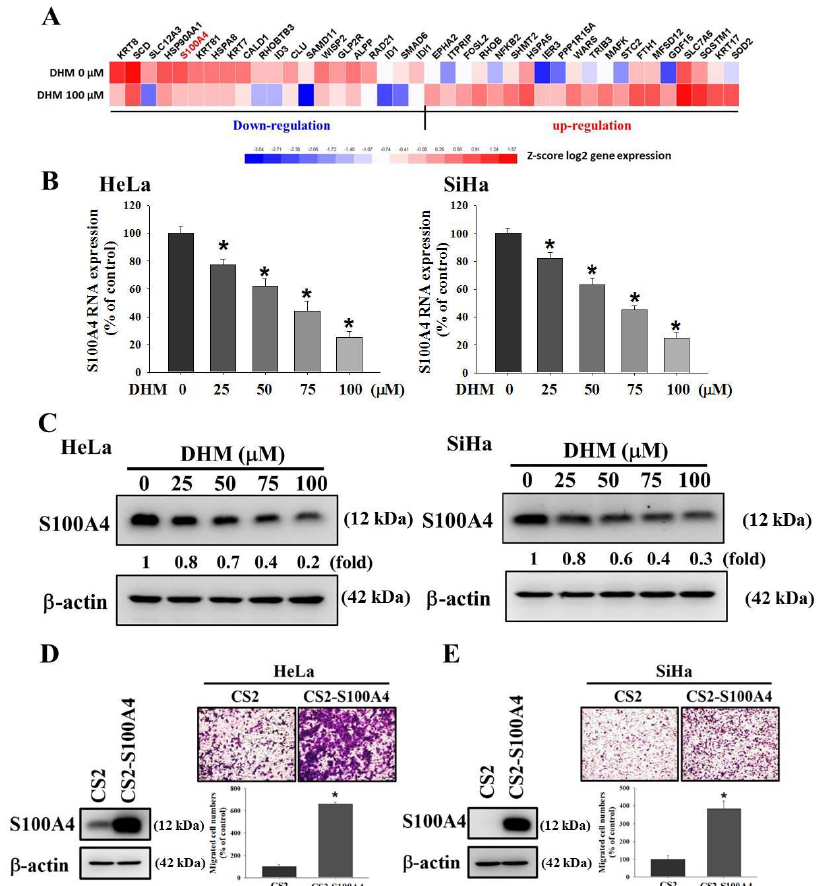
Figure 3. Effects of DHM on S100A4 expression in cervical cancer cell lines. ( A ) Heat map of the hierarchical clustering of 40 differentially expressed genes identified in HeLa cells after treatment with DHM (0, 100 µ M). ( B , C ) The RNA level and protein level of S100A4 were detected by real-time PCR and Western blotting. ( D ) HeLa and ( E ) SiHa cells were seeded onto 6 cm dish and transfected with CS2-vector or CS2-S100A4. The results were analyzed by Boyden chamber assay and Western blotting. *, p < 0.05 compared with untreated. Cells were photographed using microscope (100 ×